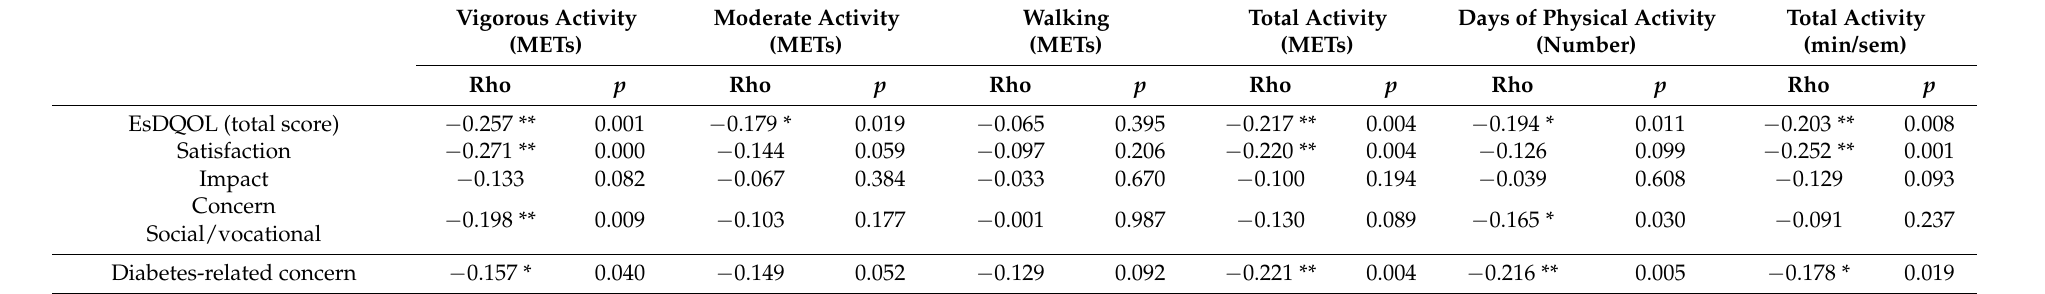
Table 2. Correlations between EsDQOL and IPAQ questionnaires in Type 1 Diabetes Mellitus population ( n = 172).